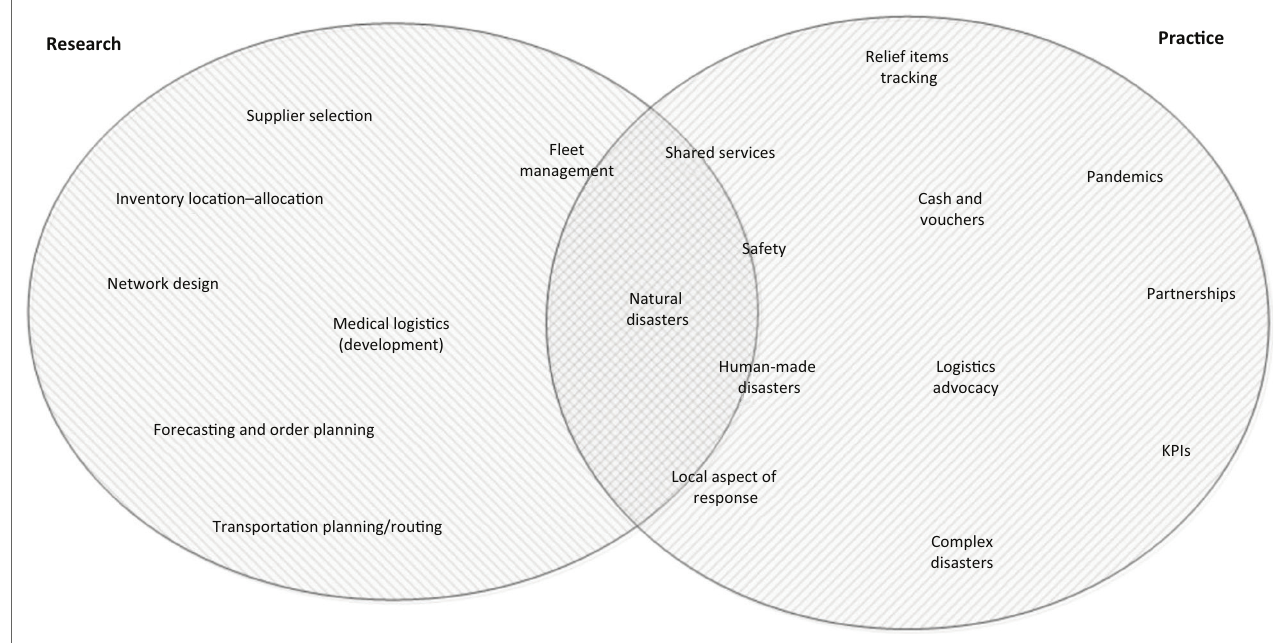
FIGURE 11: Matching research with practice in humanitarian